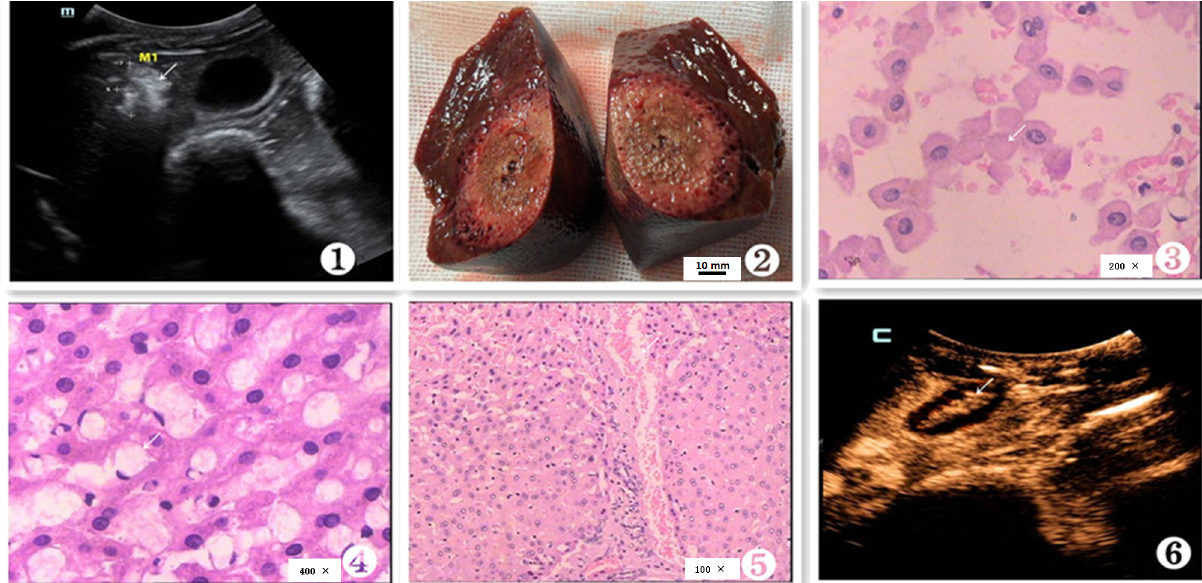
Figure 2. Representative images of conventional ultrasound (CU), contrast-enhanced ultrasound (CEUS), and the histologically stained liver lesions. 1: The ablation lesion presents an inhomogeneous hyperechoic mass according to CU (indicated by the white arrow); 2: the gross image of the radio frequency ablation (RFA) lesions of the swine livers in vitro; 3: coagulative necrotic hepatocytes inside a complete ablation lesion (indicated by the white arrow); 4: edema (indicated by the white arrow) and pyknosis of hepatocytes inside an incomplete ablation lesion; 5: reactive hyperemia zone between the ablation lesion and normal hepatic tissue (indicated by the white arrow); and 6: mass-like echo enhancement of an incomplete ablation lesion in the arterial phase according to CEUS (indicated by the white arrow).